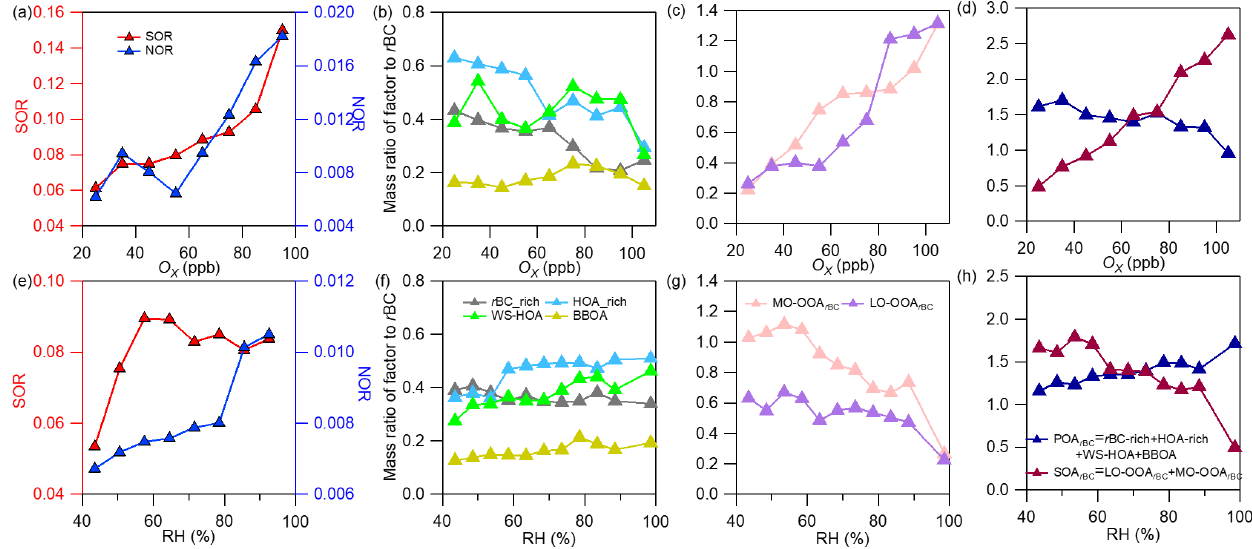
Figure 8. Plots showing variations of the nitrogen oxidation ratio (NOR) and the sulfur oxidation ratio, the mass ratios of different POA factors and SOA factors and the total POA and total SOA to rBC against O x (a–d) and RH (e–h) (NOR = n NO − − + n SO / ( n SO 2 − and SOR = n SO 2 − , n SO 2 − , n NO 2 , n NO and n SO 2 are the molar concentrations of particle-phase sulfate, 2 ), where n NO 4 4 3 4 nitrate, gaseous NO 2 , NO and SO 2 ,